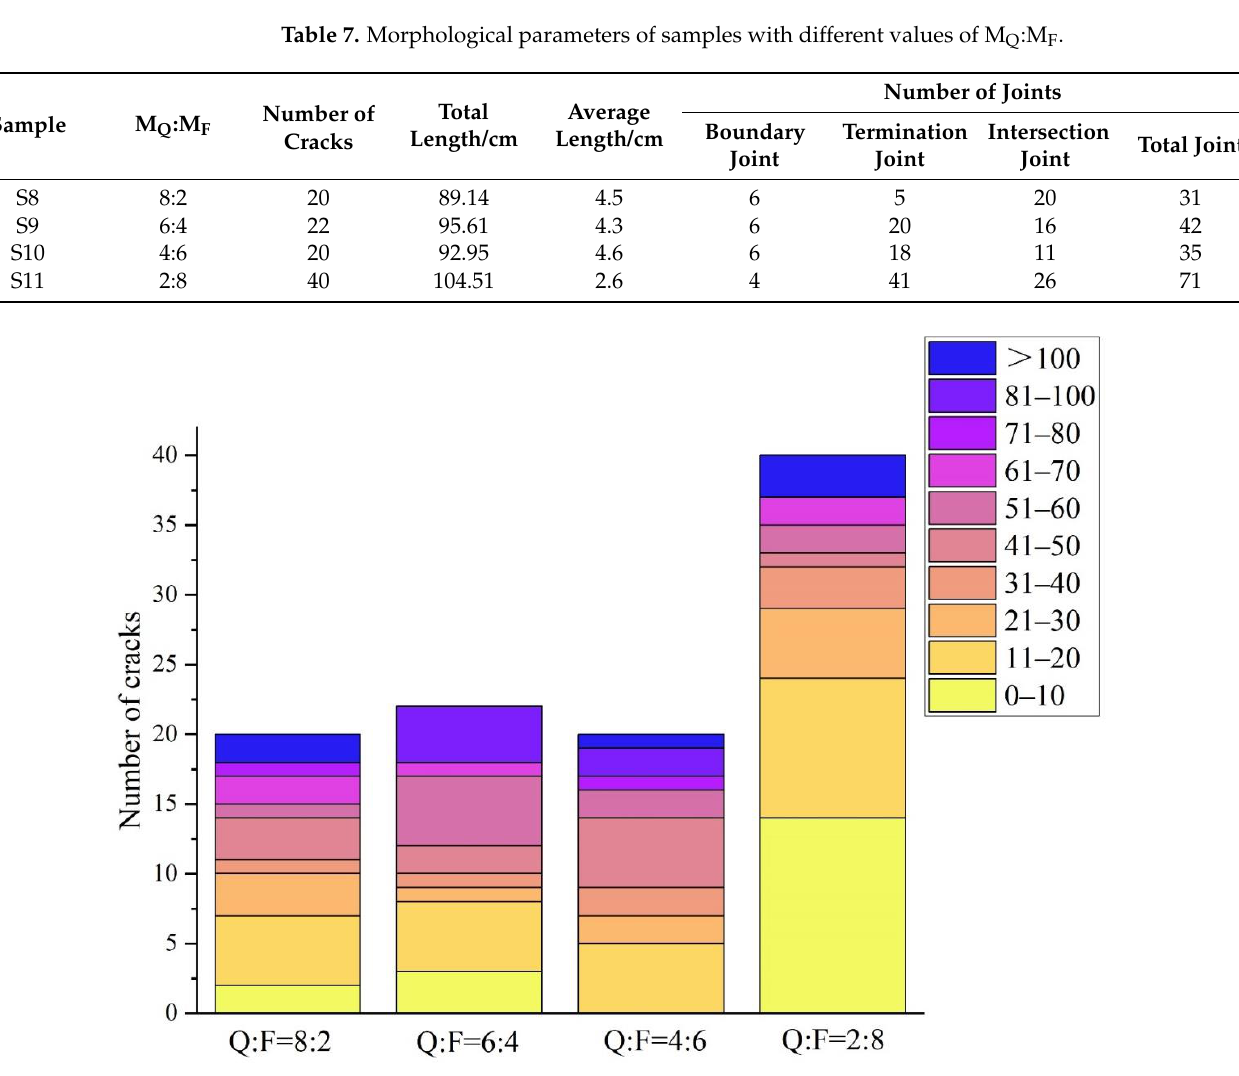
Figure 12. Crack number with different lengths under various quality ratios of quartz to feldspar.